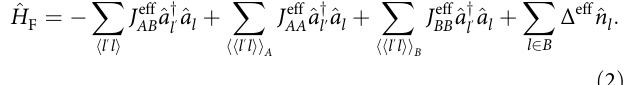
Fig. 3 Topological phase diagram. Calculated Haldane-like phase diagram of the driven hexagonal lattice with regions of different Chern number (parameters: ω = 2 π ⋅ 6410 Hz, α = 1.28, the detuning δ is varied by changing the initial offset Δ AB via the lattice depth). The experiments are performed for circular shaking (along the gray line and also for the gray point in the C = − 1 area). For the parameters of Δ AB and J AB for the varying lattice depths see Supplementary Fig.